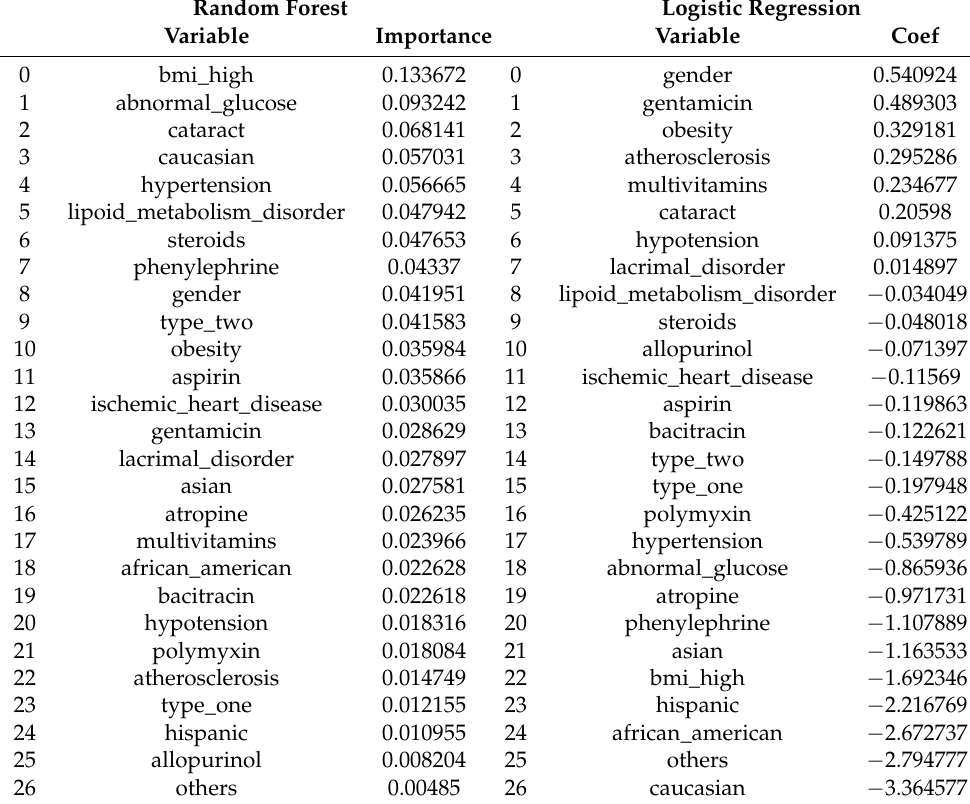
Table A2. Different futures were identified as an important variable by two different methods random forecast vs Logistic